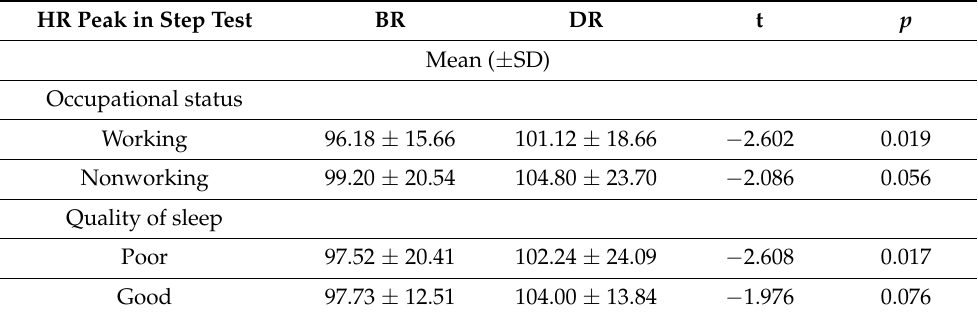
Table 7. Physical performance (mean ± SD) as estimated by the Step test according to the occupational status and quality of sleep. Values before (BR) and during (DR)